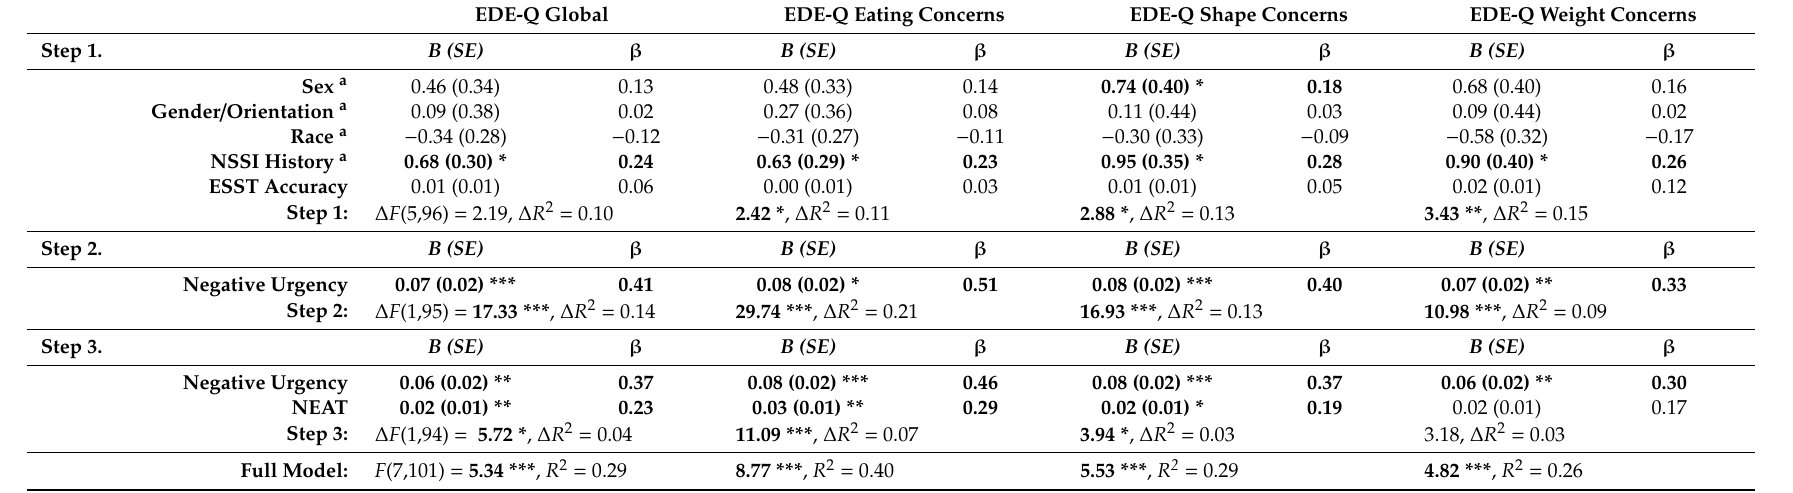
Table 3. Hierarchical linear regression analyses: Cognitive ED symptoms ( N =